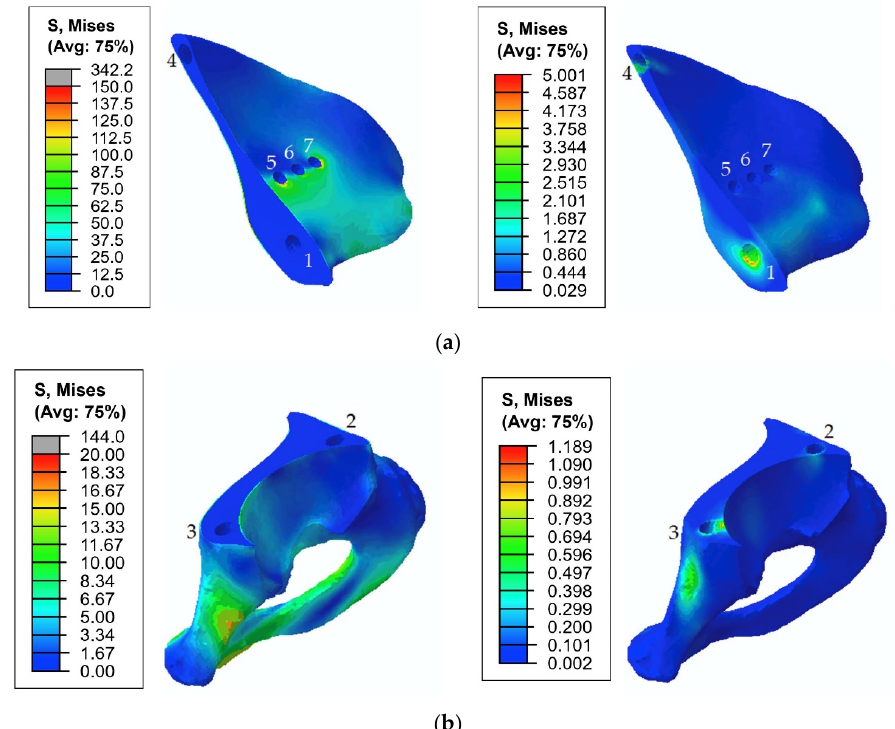
Figure 15. Equivalent von Mises stress (MPa) distribution in the bone tissue caused by the pretension load of 1000 N and joint reaction forces at 45% of the gait cycle: ( a ) the upper part of the resected pelvic bone; ( b ) the lower part of the resected pelvic bone. The images on the left show stresses in the cortical tissue, and the images on the right show stresses in the spongy tissue.